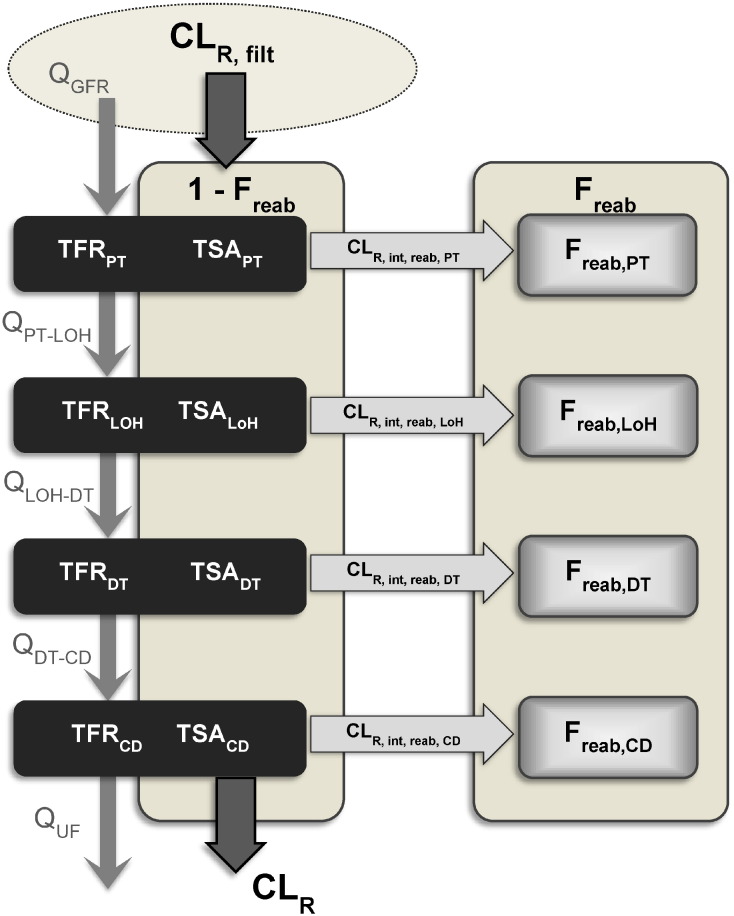
Schematic diagram of the minimal physiologically-based model for tubular reabsorption of drugs in the kidney. The nephron is represented by a glomerulus compartment in addition to four compartments representing different regions of the nephron tubule (proximal tubule (PT), loop of Henle (LoH), distal tubule (DT) and collecting duct (CD) in descending anatomical order). Physiological parameters, tubular flow rate (TFRi) and tubular surface area (TSAi), for each individual tubular region are indicated. Tubular filtrate flow (Q) is represented by grey arrows connecting tubular compartments and used to calculate TFRi (average midpoint flow rates). The intrinsic reabsorption clearance of each individual region (CLR,int,reab,i) is calculated using the corresponding TSAi. Total renal excretion clearance (CLR) is obtained from the filtration clearance (CLR,filt) and the overall fraction reabsorbed (Freab), by rearrangement of Eq. (9).